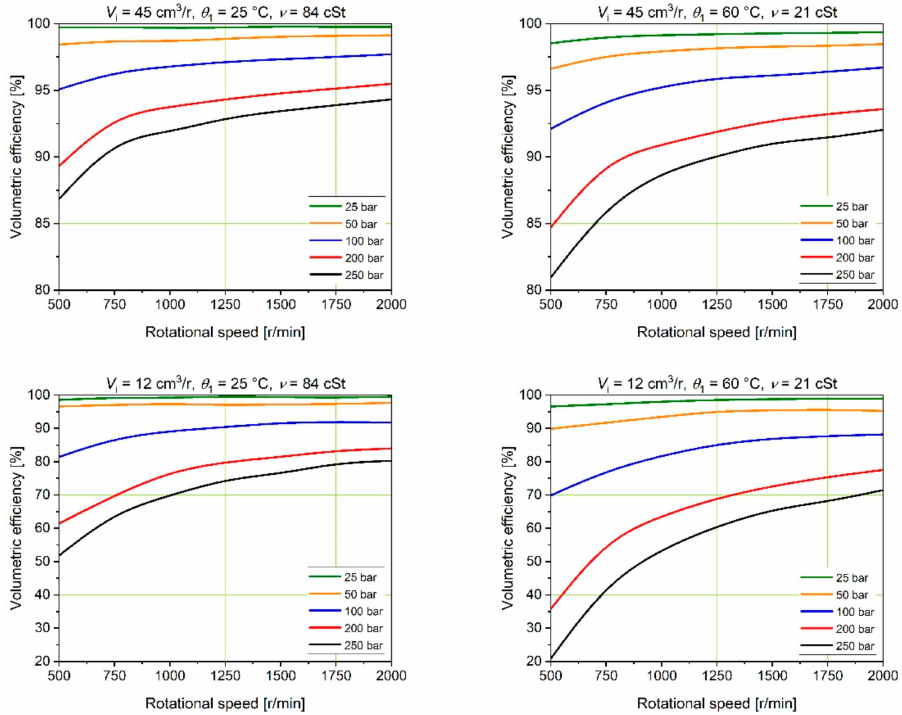
Figure 11. Volumetric efficiency of an axial piston pump as a function of rotational speed with five constant pressures. The seven-calculation-point efficiency curves have been smoothed with B-splines. Note the varying efficiency scales.